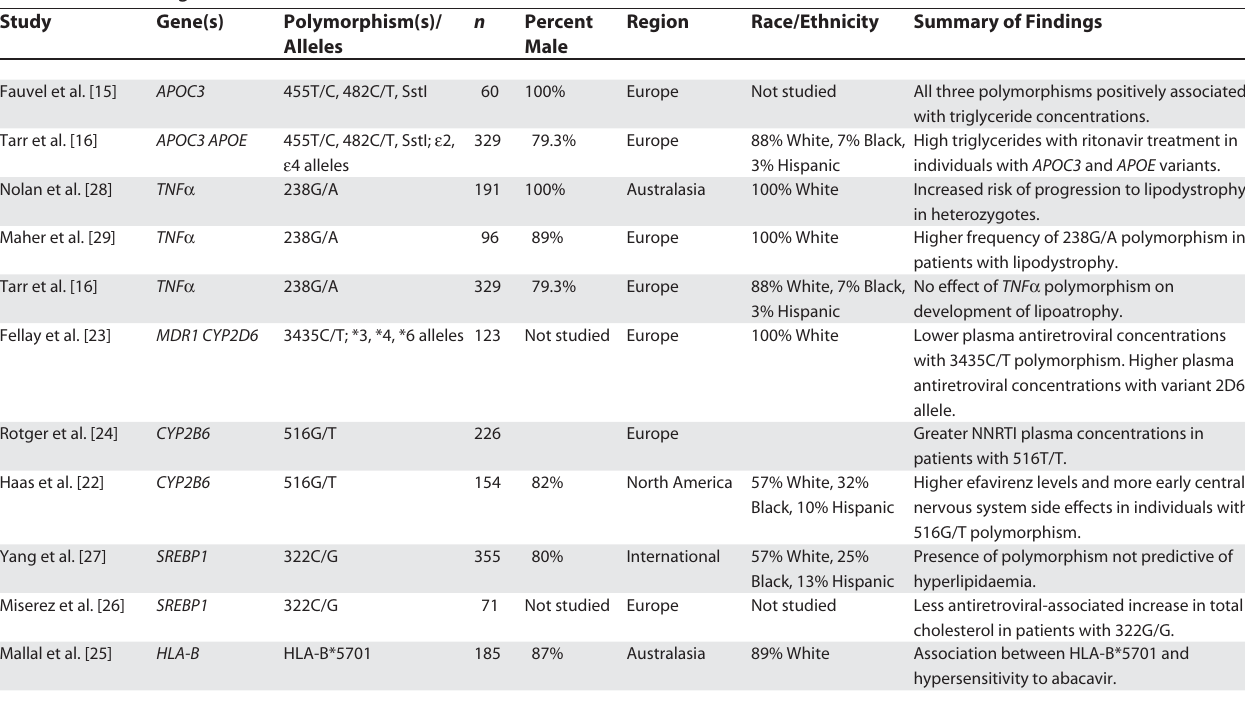
Table 1. Pharmacogenetic/Genomic Studies in HIV